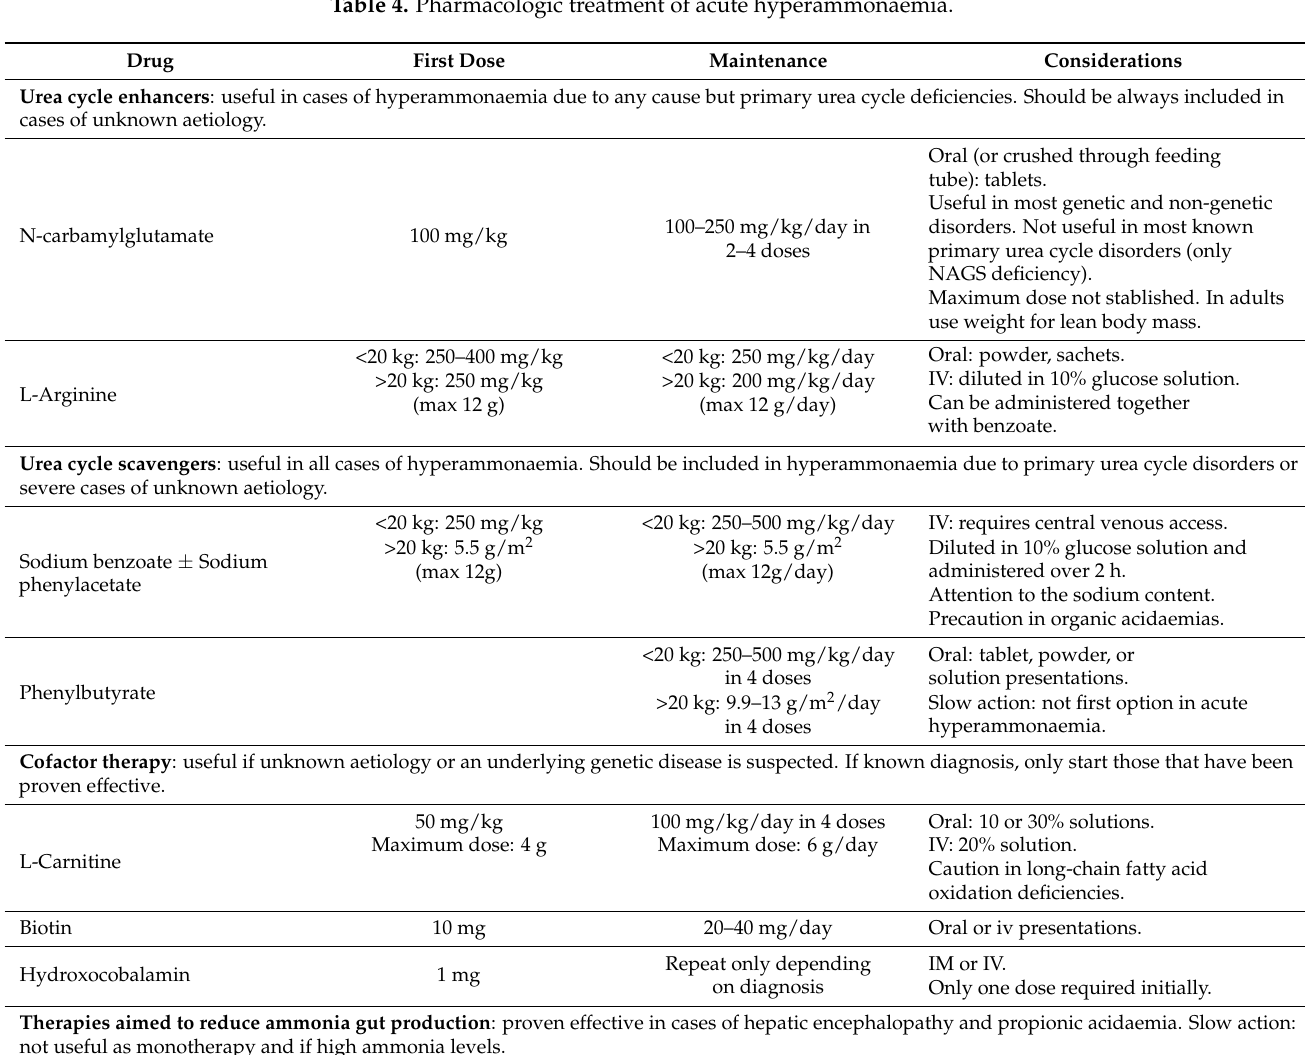
Table 4. Pharmacologic treatment of acute